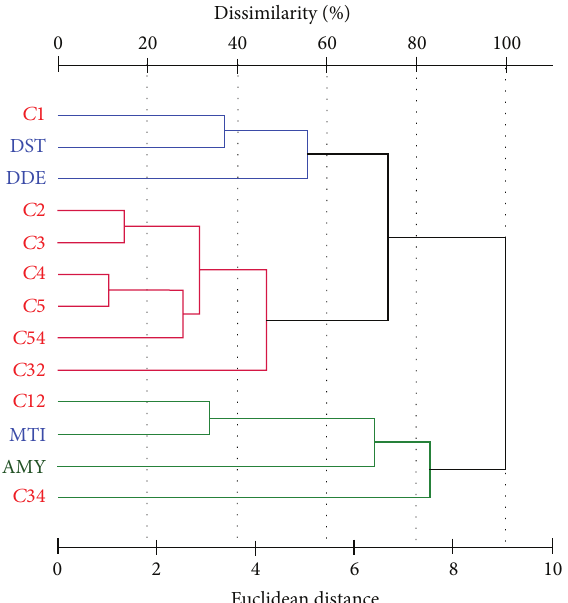
Figure 2: Cluster analysis between farinograph, amylograph, and mixolab parameters. Farinograph data: DDT: dough development time, DST: dough stability, MTI: mixing tolerance index; amylograph data: AMY: viscosity maximum; Mixolab torque data: C1–C5, and their pair differences C12, C32, C34, and